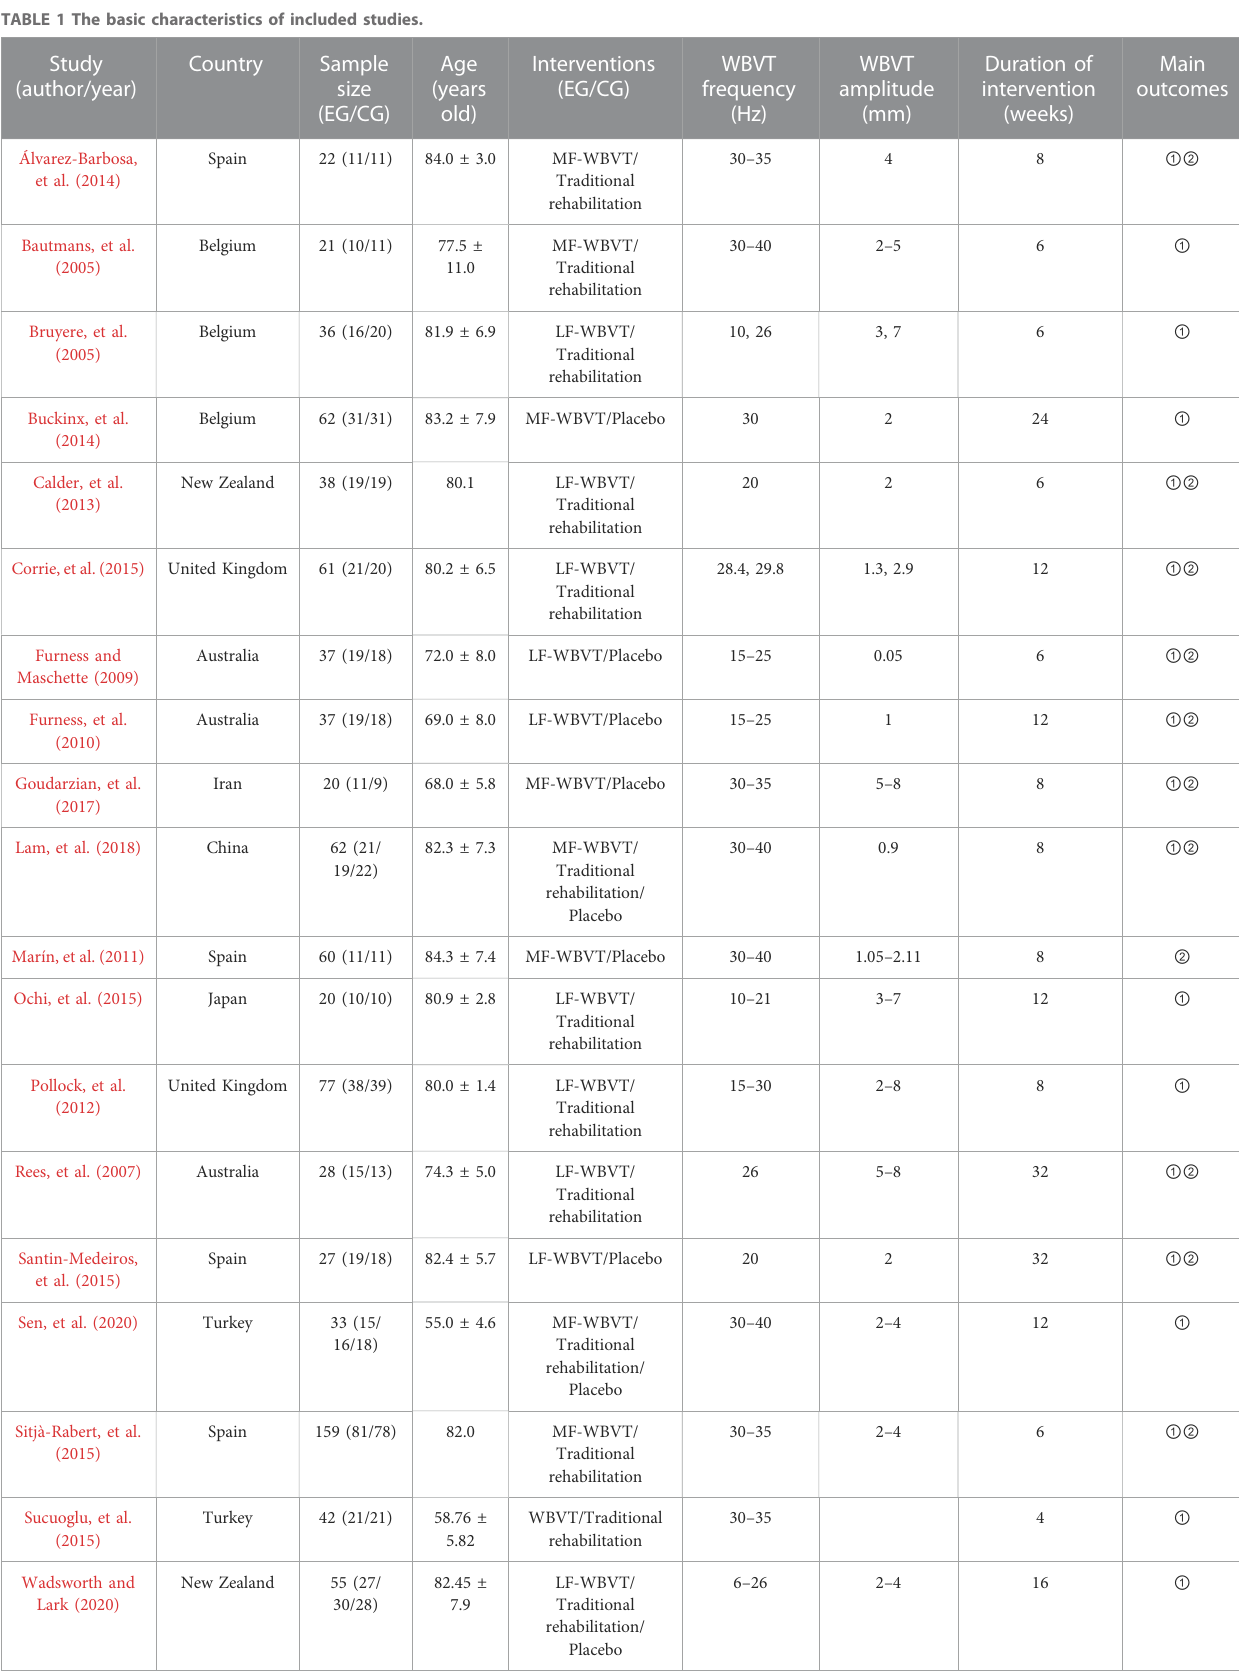
TABLE 1 The basic characteristics of included